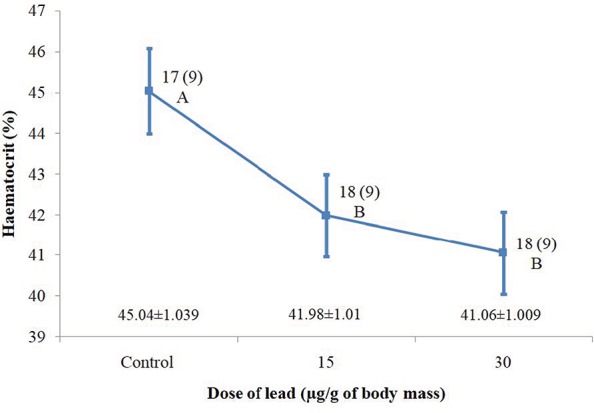
Haematocrit variation of great tit nestlings that were experimentally supplemented with lead acetate solution in comparison with control individuals. Mean ± standard errors calculated from the linear mixed model are shown. Sample sizes are shown as the number of nestlings and, in parentheses, as the number of broods. Differences among control and treatment groups using a Fisher’s LSD test are shown by letters ‘A’ and ‘B’. Means with the same letter indicate a non-significant test result